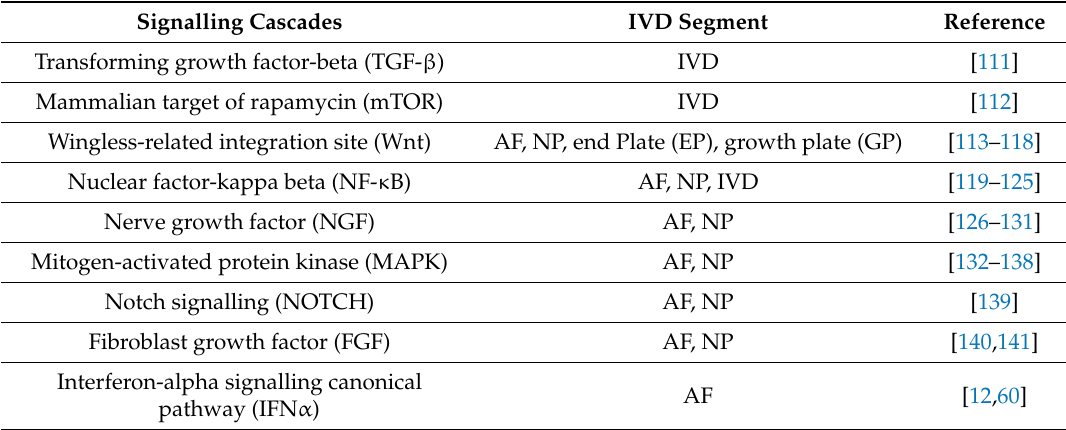
Table 2. Di ff erent HMW HA and HA-based therapeutic platforms were tested in vitro, in vivo and human trials to repair the disc (Figure 2). Table 1. Dysregulated signalling cascades in the degenerated